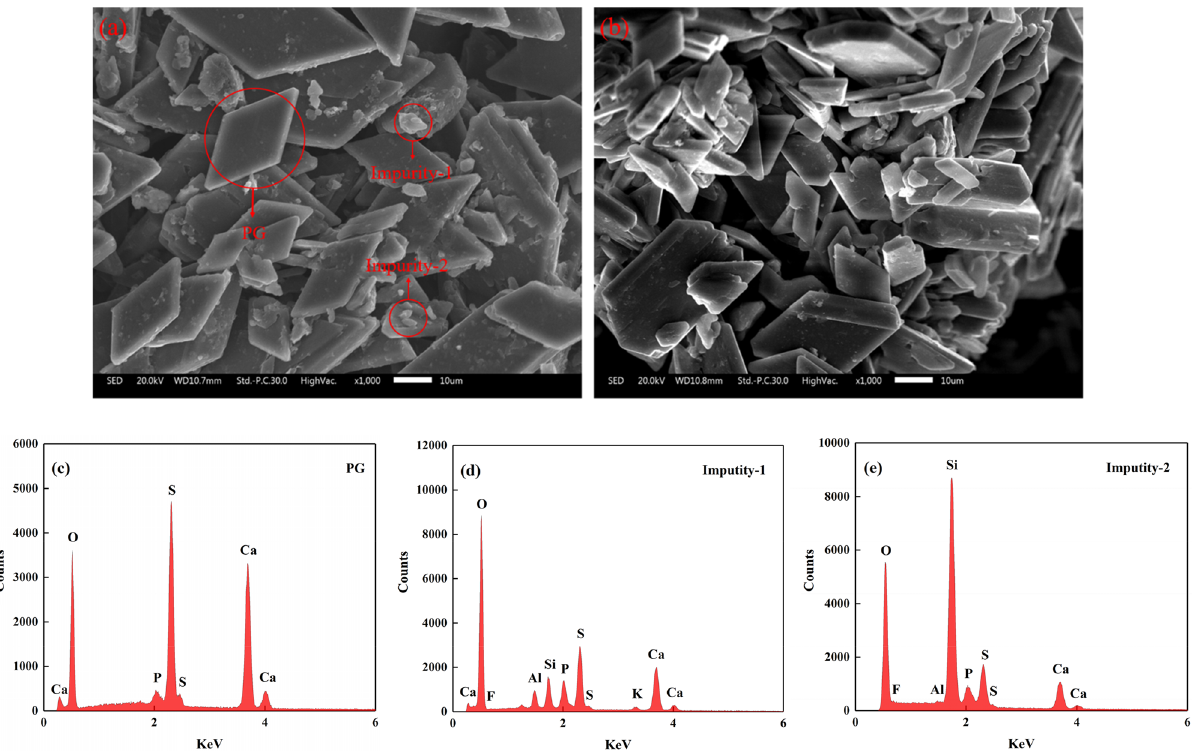
Figure 4. SEM images of PG: ( a ) original PG-1 with a pH value of 1.75, ( b ) pretreated PG-1 with a pH value of 5.15, ( c ) EDS of PG, ( d ) EDS of impurity-1, ( e ) EDS of